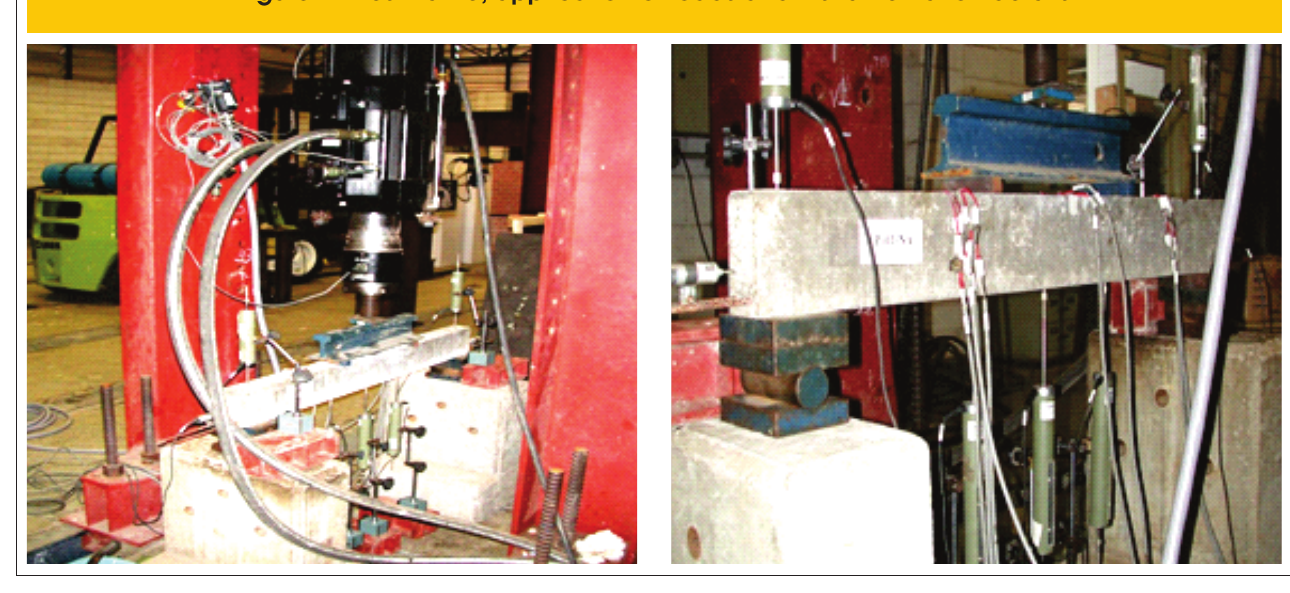
Figure 4 – Test frame, application of loads and instrumentation details